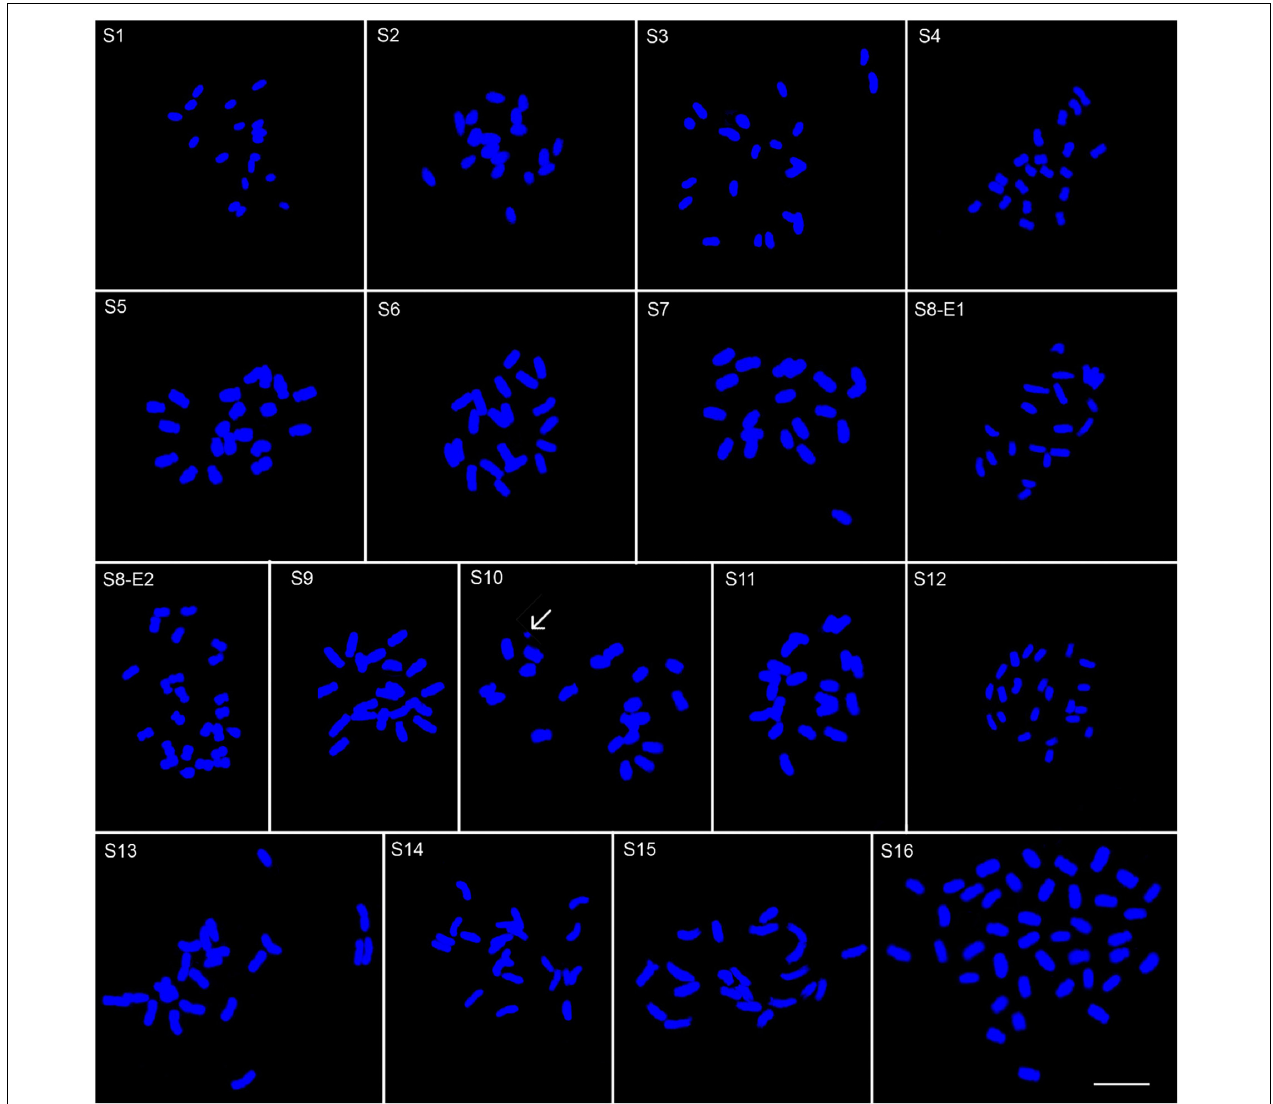
FIGURE 2 | Somatic chromosomes of 17 Pimpinella populations of 16 species: S1 ( P. affinis , x = 9), S2 ( P. eriocarpa , x = 9), S3 ( P. tragium , x = 10), S4 ( P. saxifrage , x = 10), S5 ( P. aurea , x = 10), S6 ( P. tragioides , x = 10), S7 ( P. olivieri , x = 10), S8 ( P. khayyamii , E1: x = 10; E2: x = 12), S9 ( P. kotschyana , x = 10), S10 ( P. deverroides , x = 10), S11 ( P. olivierioides , x = 10), S12 ( P. anthriscoides , x = 11), S13 ( P. anisactis , x = 11), S14 ( P. peucedanifolia , x = 11), S15 ( P. khorasanica , x = 11), and S16 ( P. rhodantha , x = 20) Scale bar indicates 10 µ m. The arrow shows the B-chromosome.